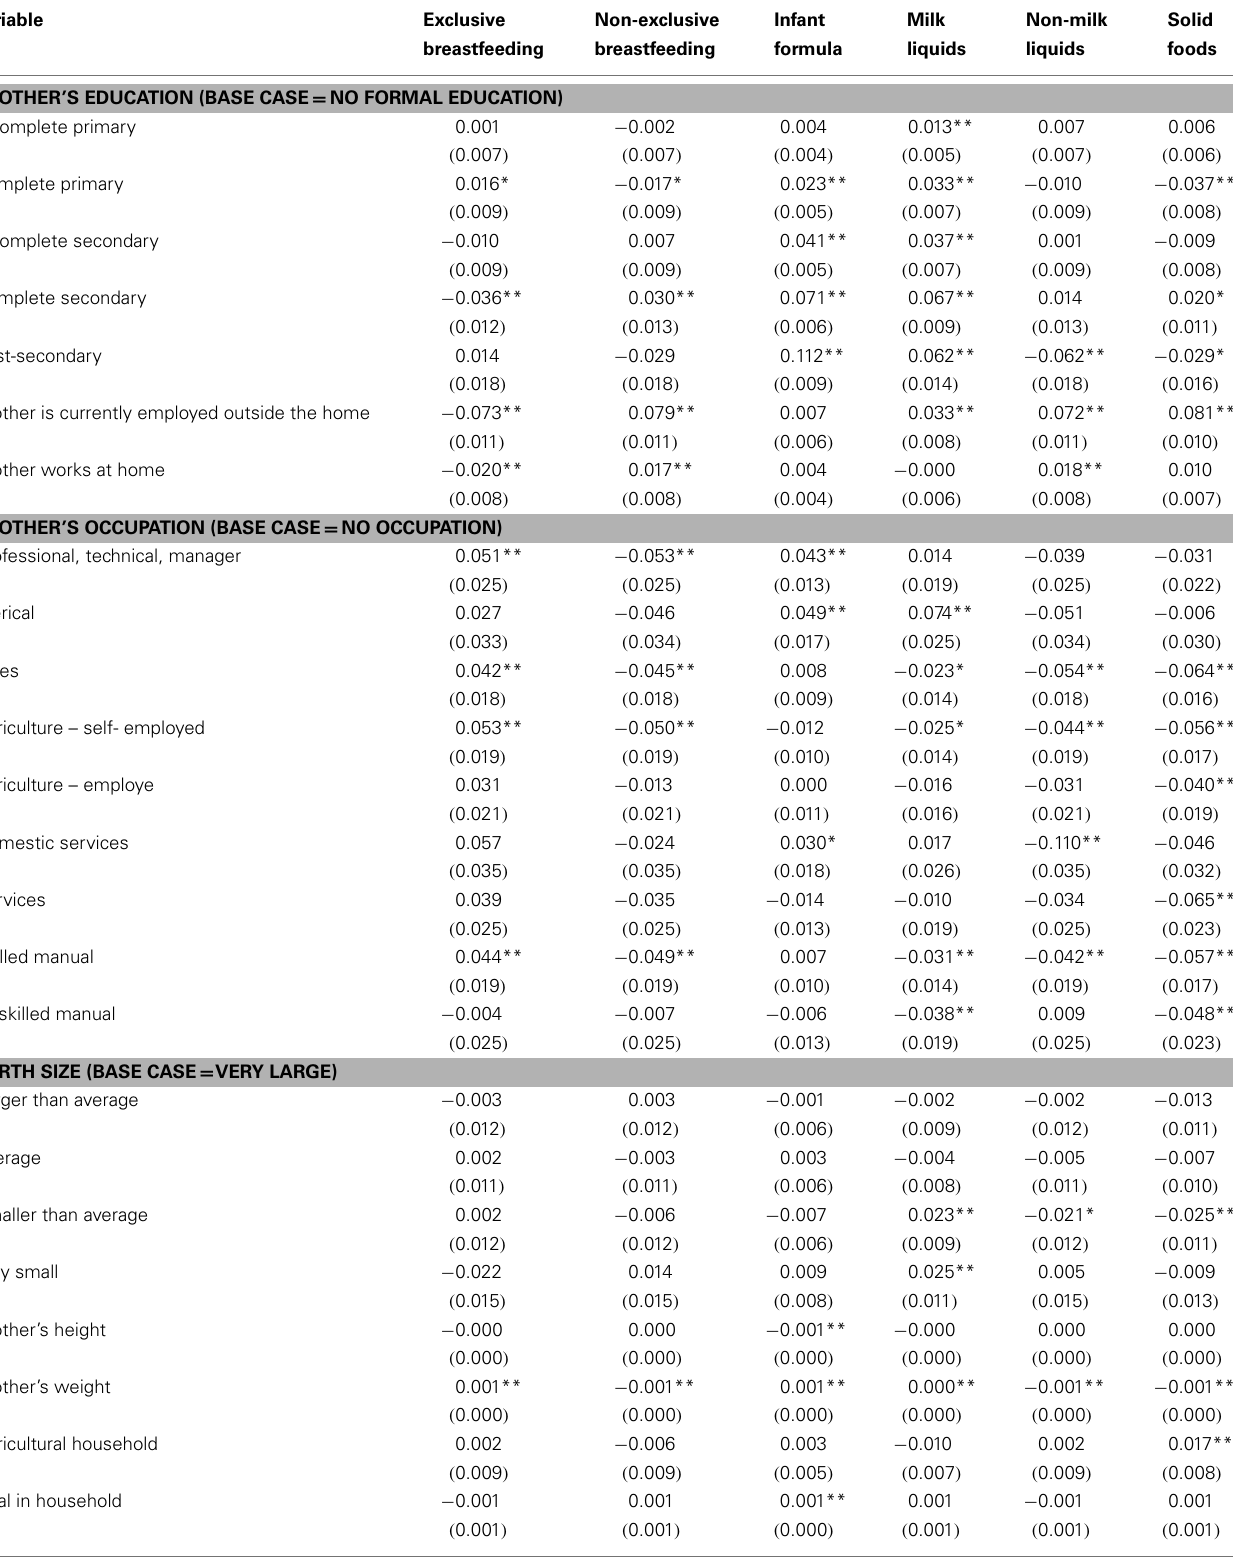
Table 2 |Associations with feeding type, age < 6months